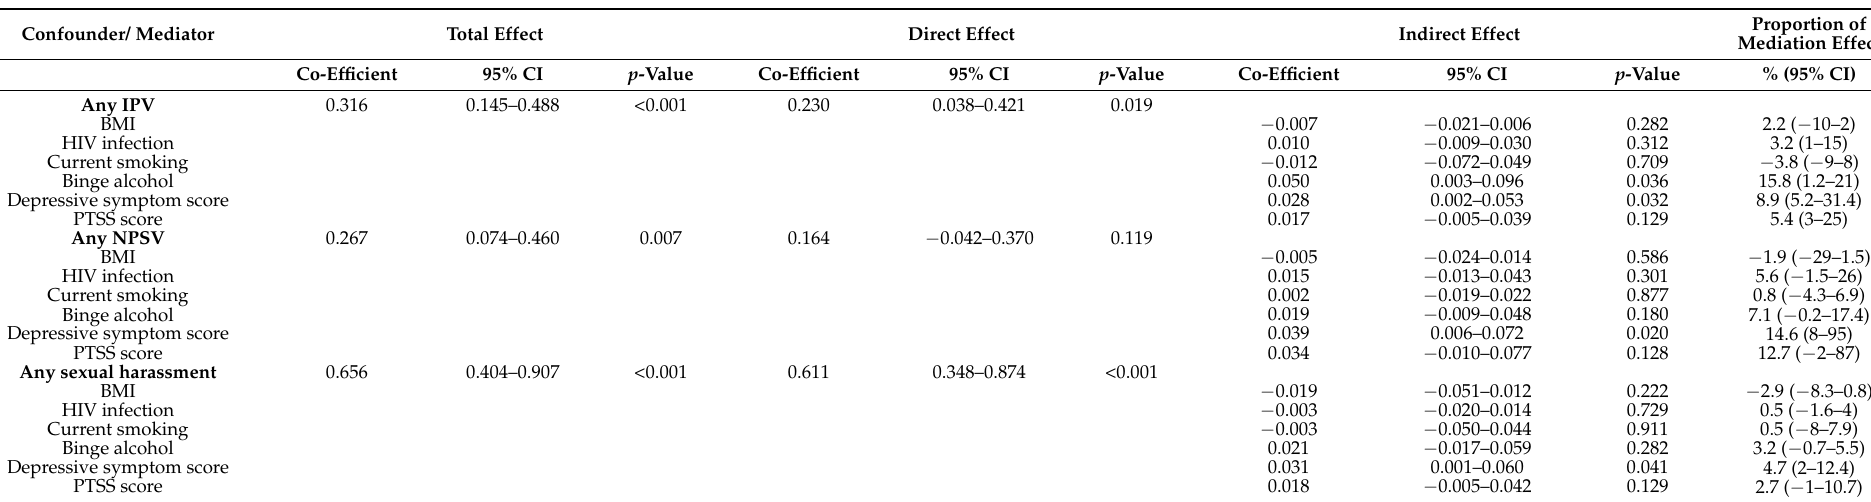
Table 5. Multiple mediation analysis for the effects of lifetime intimate partner violence (IPV), non-partner sexual violence (NPSV) and sexual harassment with hypertension ( n =